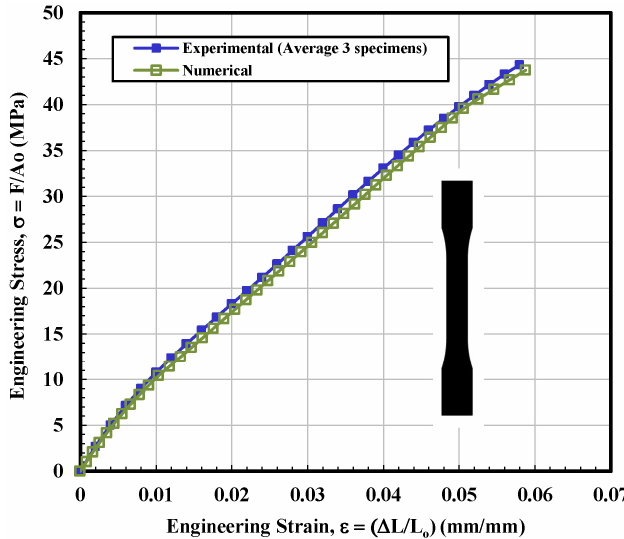
Figure 11. Engineering stress–strain curves for solid tested specimens based on experimental and finite element analysis.